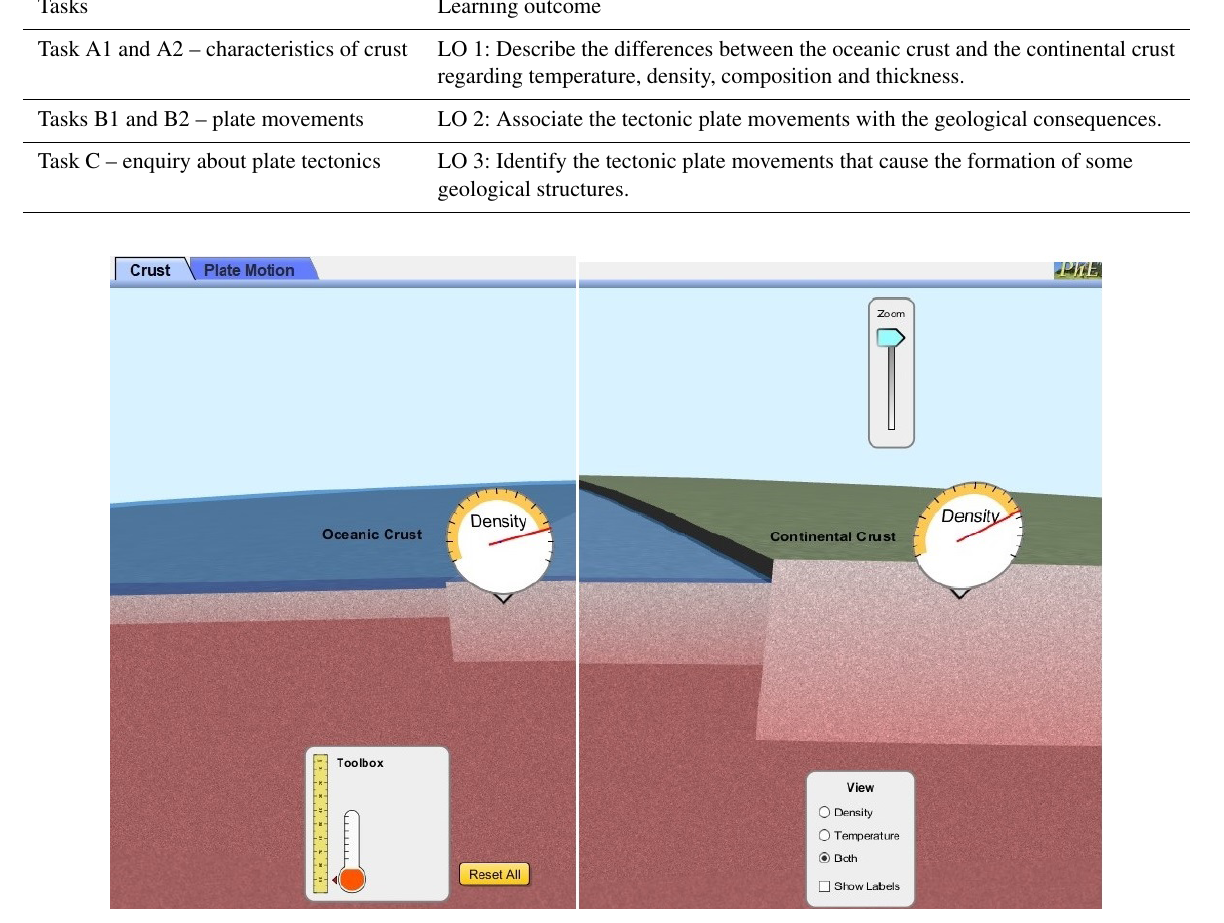
Figure 1. Density values of oceanic and continental crust. Caption from PhET™ Plate